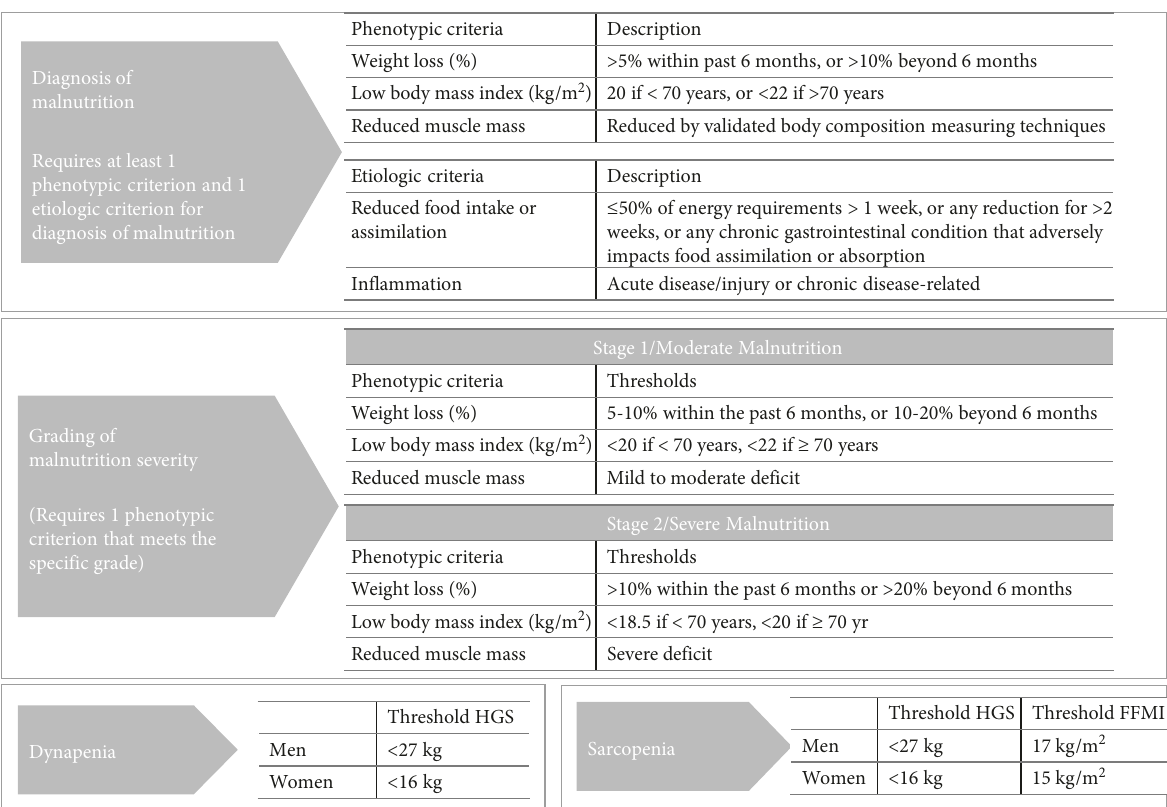
Figure 1: Summary of the criteria followed for the diagnosis of malnutrition, dynapenia, and sarcopenia in the study population [12, 28] HGS: hand grip